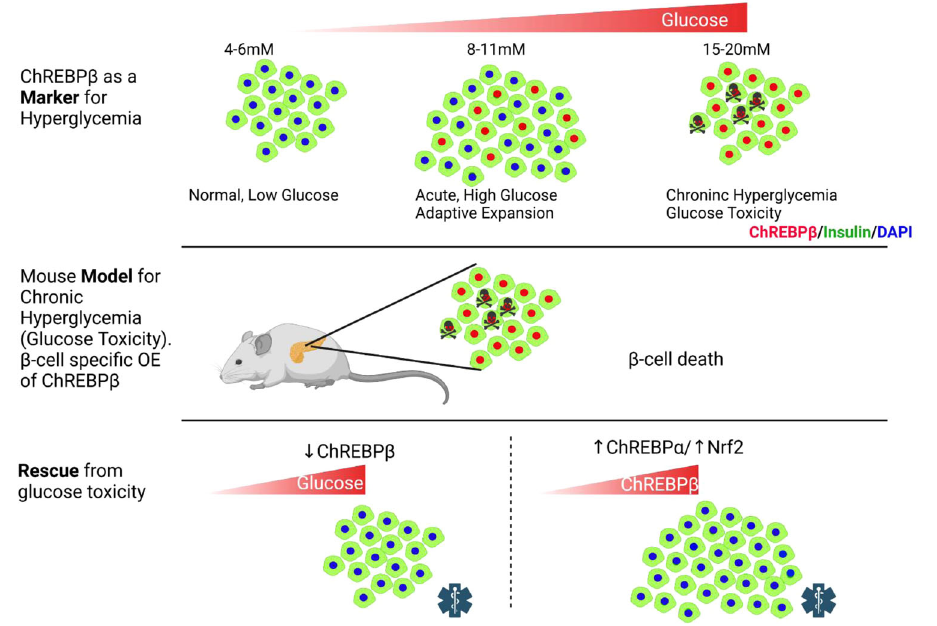
Fig. 9 | ChREBP β is required for adaptive β -cell expansion but contributes to glucose toxicity with prolonged hyperglycemia and effects of its over- expression can be rescued by activation of the Nrf2 antioxidant pathway. Nuclear expression of ChREBP β increases in β -cells with increased glucose con- centrations. Loss of function experiments demonstrate that ChREBP β is necessary